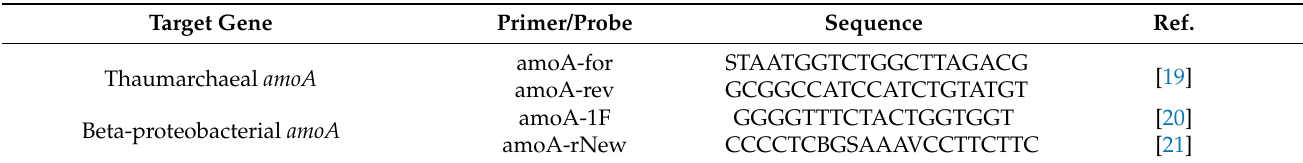
Table 1. Primer/probe information used in qPCR assays.